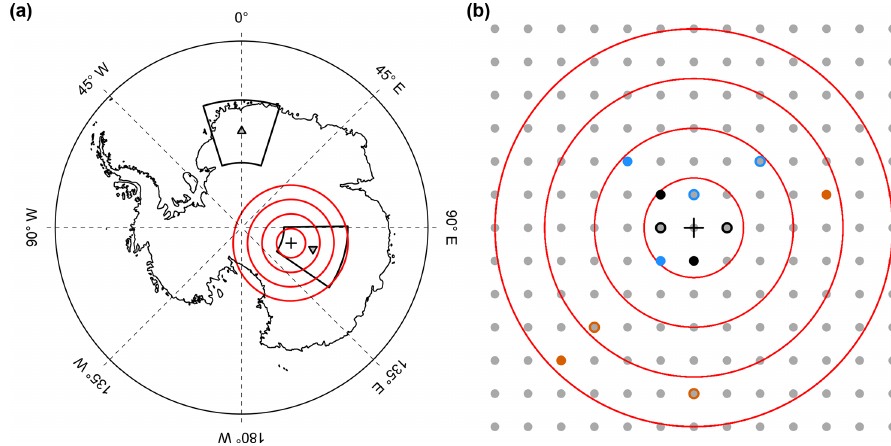
Figure 1. Conceptual sketch of the ring sampling approach. Around a given Antarctic target site (black crosses in a and b ) we define consecutive rings of 250km radial width (red lines in a and b ). From the array of available model grid cells (grey points in b ), we choose sets of grid cells which consist of N (cid:96) cells and which are drawn from N (cid:96) radial bins determined by a selected combination of rings. As an example for N (cid:96) = 2, possible grid cell sets are shown for the cases of (i) combining the innermost ring with itself (grid cells marked black), (ii) combining the innermost ring with the second ring (grid cells marked blue), and (iii) combining the third and the fourth ring (grid cells marked orange). Also shown in ( a ) are our main study regions (black polygons) around the EDML (upward-pointing triangle) and Vostok (downward-pointing triangle) ice-core sites. The ring width of 250km is chosen as a trade-off between high spatial resolution and the requirement that a sufficient number of grid cells lie inside each ring. Note that for aesthetic reasons, only four rings are displayed instead of the actually used nine rings and that the model grid is shown simplified as a regular grid in